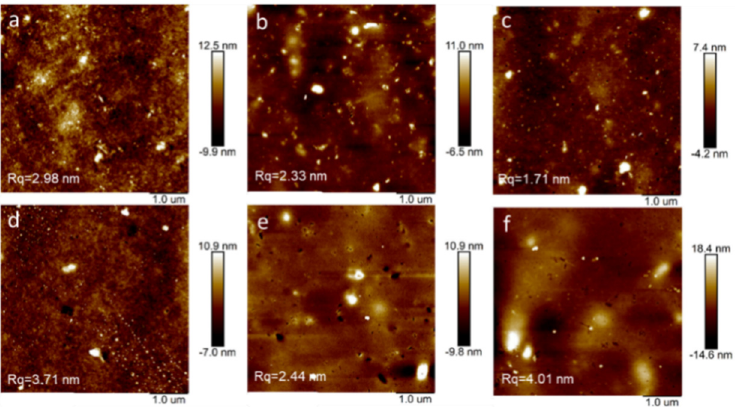
Figure 5. AFM images of P1 ( a ), P2 ( b ), and P3 ( c ) pristine films and P1 ( d ), P2 ( e ), and P3 ( f ) films doped with FeCl 3 (0.1 M) for 15 min.